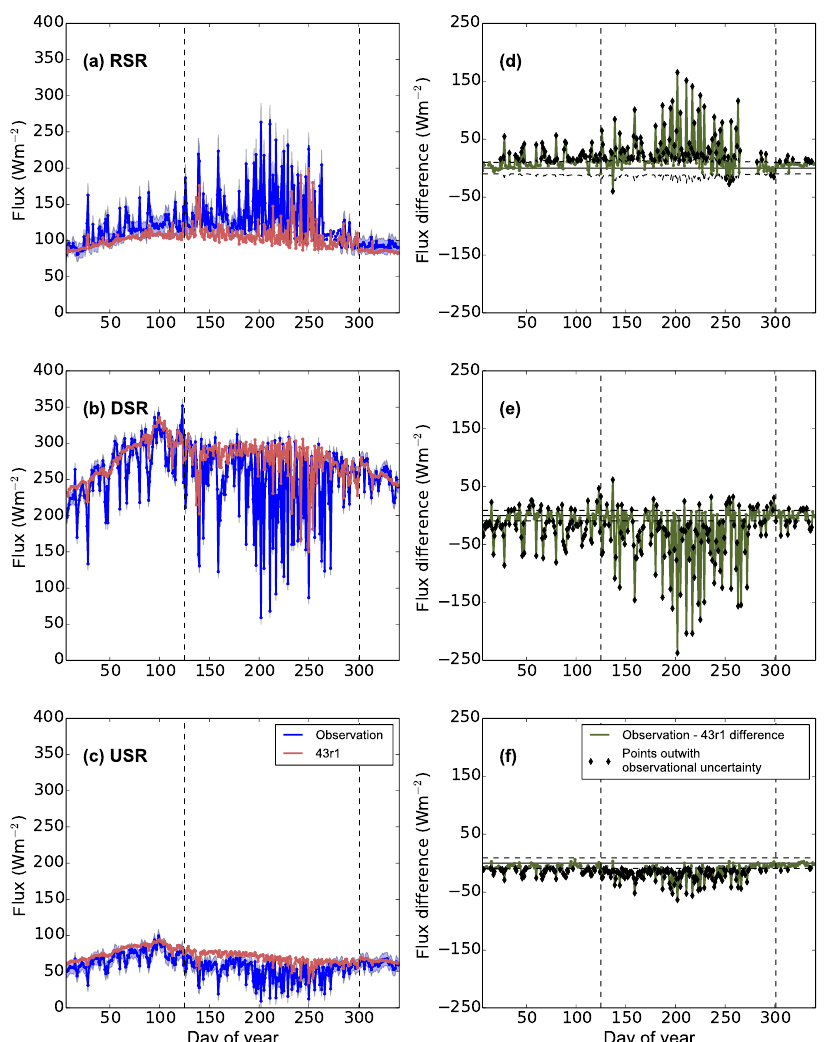
Figure 2. Daily means of observed (blue, from AMF and GERB) and 43r1 (red) shortwave radiation fluxes at Niamey during 2006. Lines become dashed when values are from interpolation (see Sect. 3). Plots show observed and 43r1 (a) TOA reflected shortwave; (b) surface downwelling shortwave; (c) surface upwelling shortwave radiation fluxes; and the observation–43r1 difference of these same fluxes in plots (d) – (f) , respectively. Black diamonds on plots (d) – (f) indicate model values outside of the observational uncertainty range (horizontal dashed lines). Vertical dashed lines indicate the beginning and end of the wet